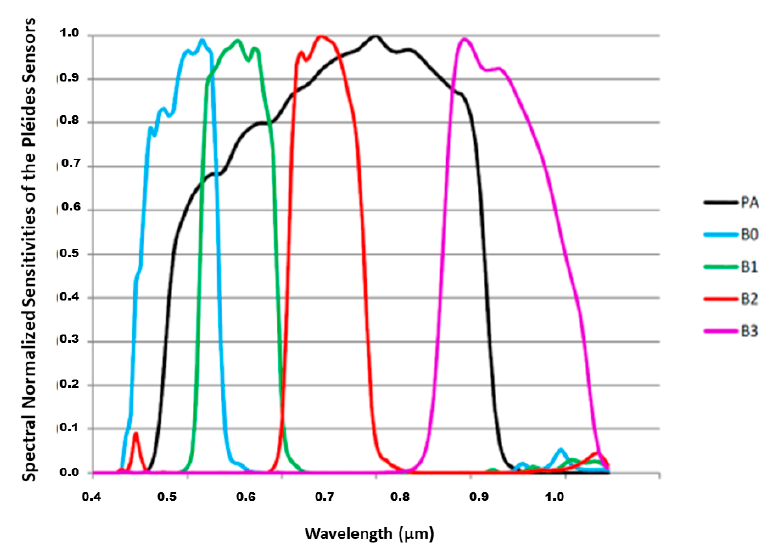
Figure 4. Spectral resolution of the Pleiades sensors (http://www.gstdubai.com/satelliteimagery/pleiades-1a.html).